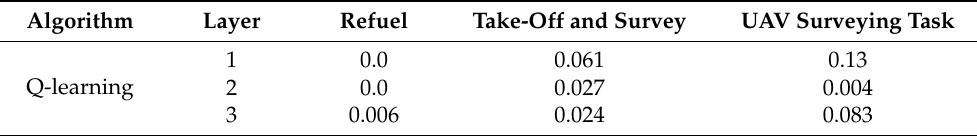
Table 2. The standard deviation for each subtask per layer completion for